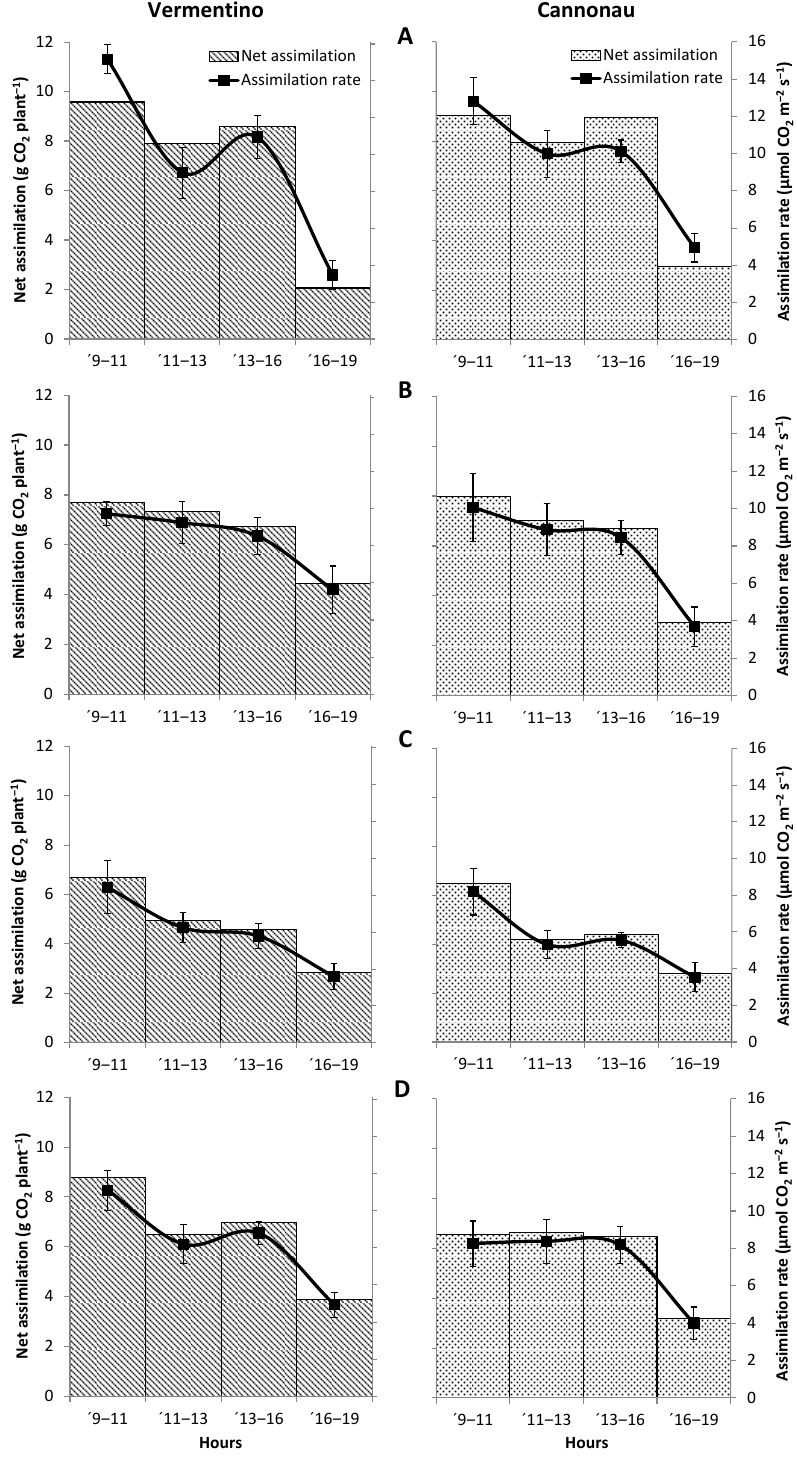
Figure 5. Daily net carbon assimilation per plant and net assimilation rate over a sunny day at BBCH stages 71 ( A ), 80 ( B ) 83 ( C ), and 85 ( D ) in Vermentino (left) and Cannonau (right), at the Romangia site, during season 2019. Values are the mean ± standard error.